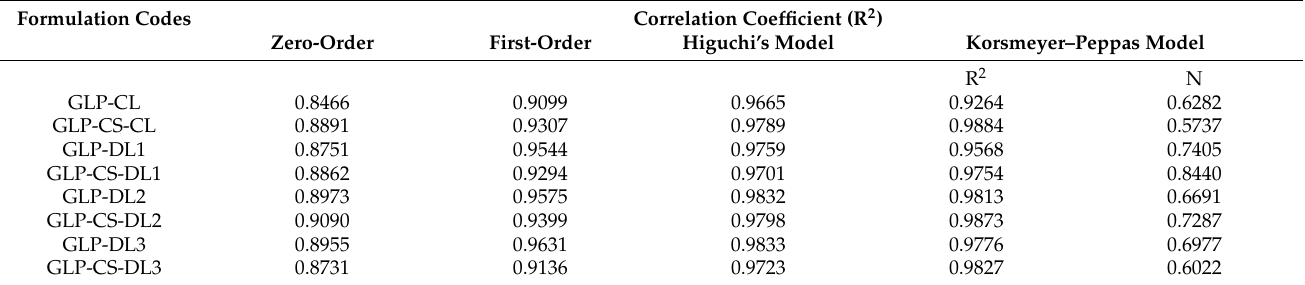
Table 3. In vitro release kinetics models of GLP-loaded CL-, DL-, and CS-coated CL/DL in PBS solution (pH 7.4) containing 0.5% Tween